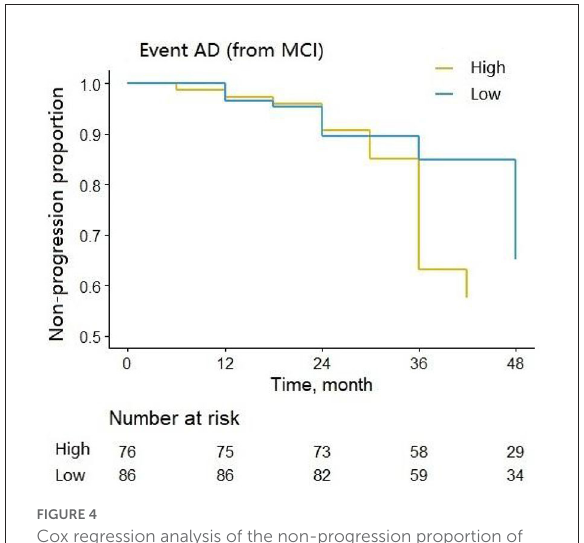
FIGURE4 Cox regression analysis of the non-progression proportion of MCI patients with different CSF 14-3-3 ζ